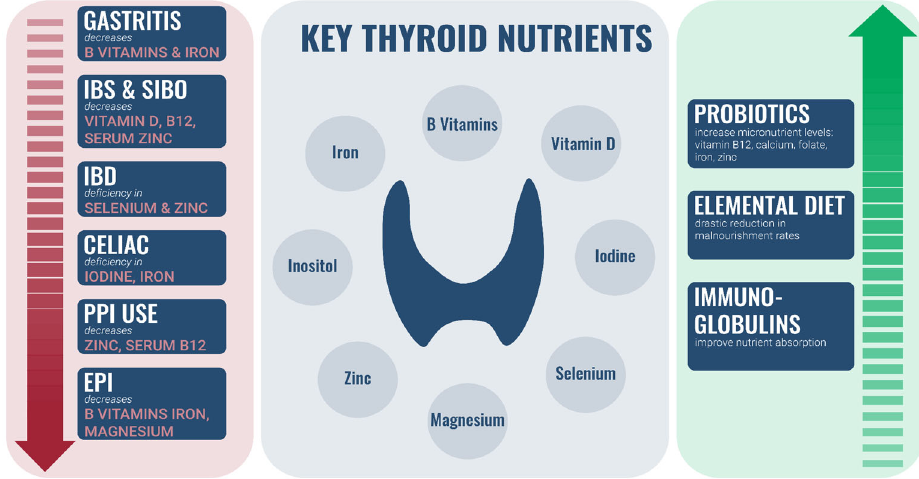
Figure 2. Relationship between nutrients, GI dysfunction, and GI ‐ focused care.